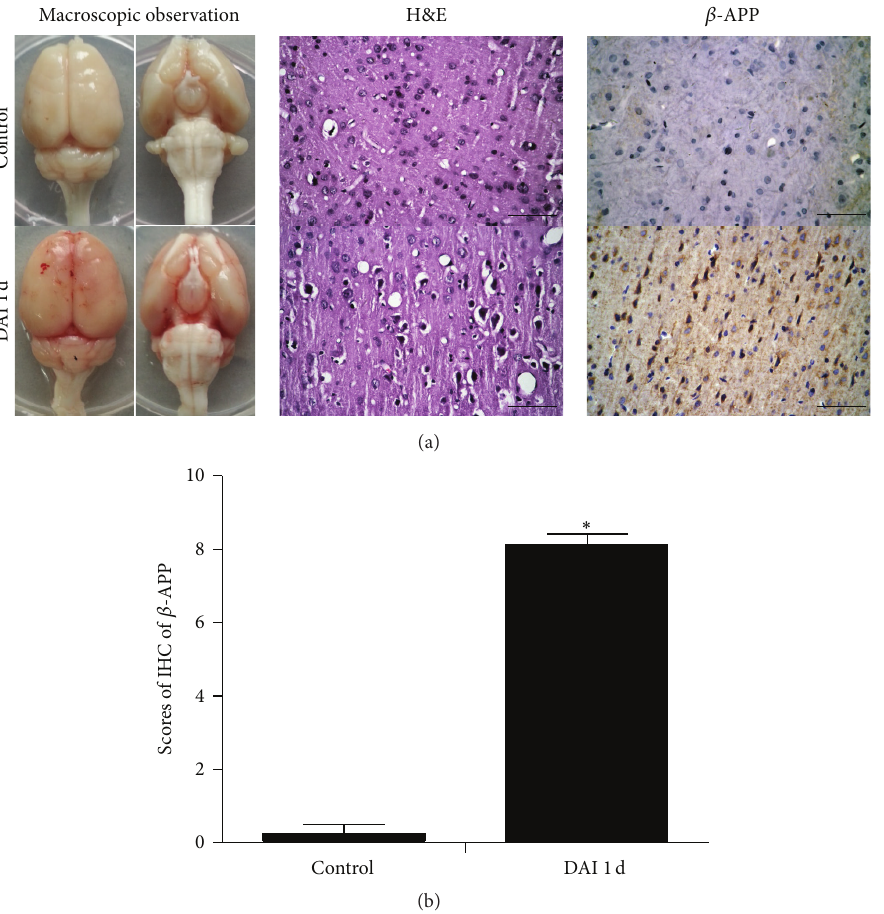
Figure 1: Pathological changes in the rat cortex after DAI. (a) Pathological changes after DAI were confirmed by macroscopic observations, H&E staining, and 𝛽 -APP immunohistochemistry. Scale bar = 50 𝜇 m. (b) The bar graphs show the 𝛽 -APP expression results in the cortex ( 𝑛 = 6 ; ∗ 𝑝 < 0.05 ,comparedwithcontrolgroup). 𝛽 -APPlevelswereassessedin5randomfields(40xmagnification)viaimmunohistochemical scores (IHS). Values are presented as the mean ±